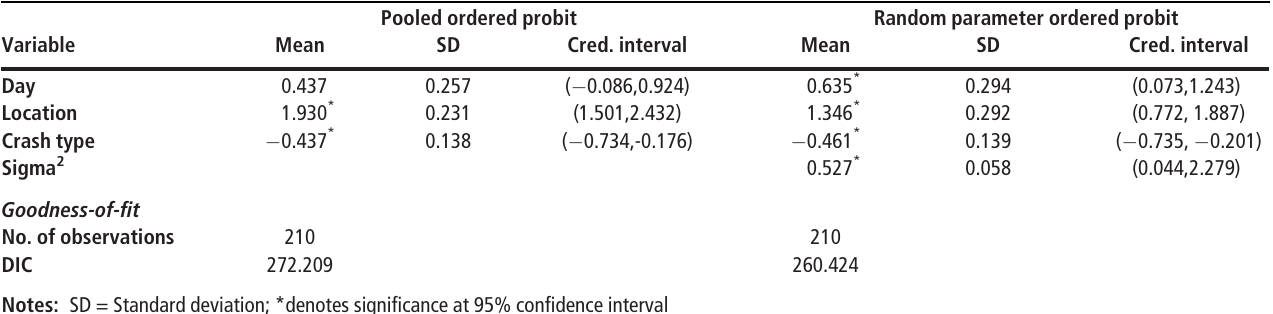
Table 2 Injury severity results for Bayesian pooled ordered probit and Bayesian random parameter ordered probit models Pooled ordered probit